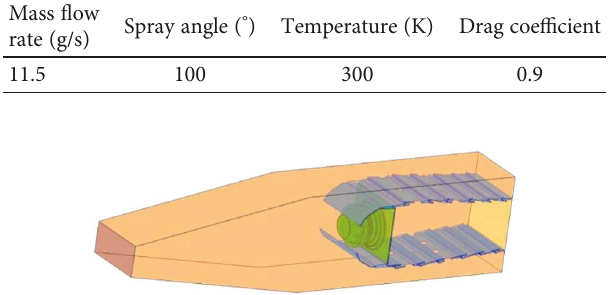
Figure 5: The radial pro fi le comparison of fl ame B at 20 jet Table 2: Parameters of the pressure-swirl atomizer model.